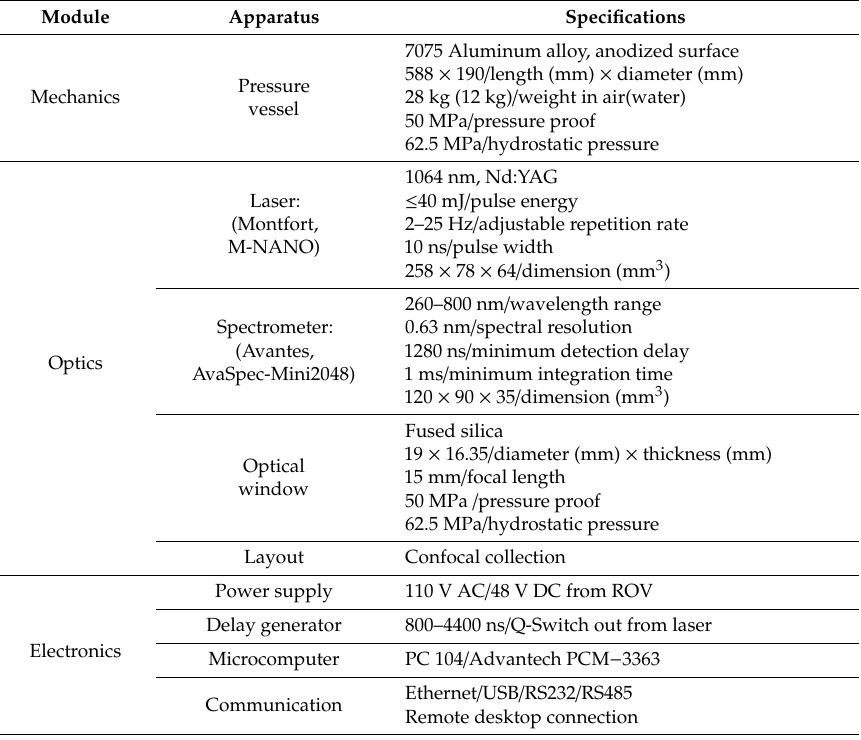
Table 1. General Specifications of the LIBSea II